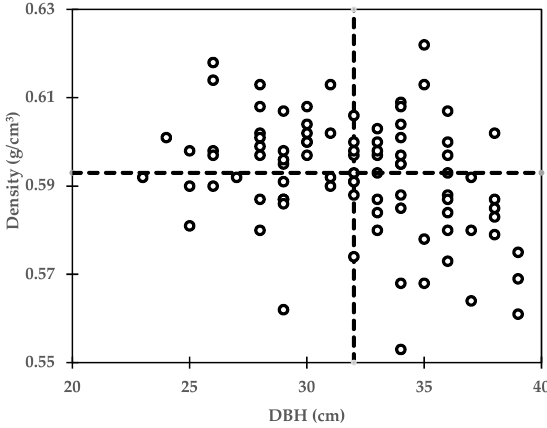
Figure 3. Selection strategy using individuals with both high density and DBH. Dotted lines are current family means for density and DBH acting as a base (control).